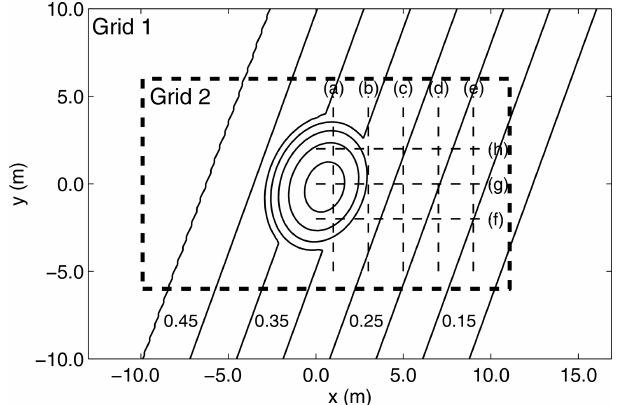
Figure 8. Computational domain and bottom topography of Berkhoff et al. (1982) experiments of wave transformations over a tilted elliptical shoal on a sloping bottom. The bold dashed line box marks the area of the nested grid, Grid 2. Dashed lines (a) – (h) are transects for model–data comparisons.